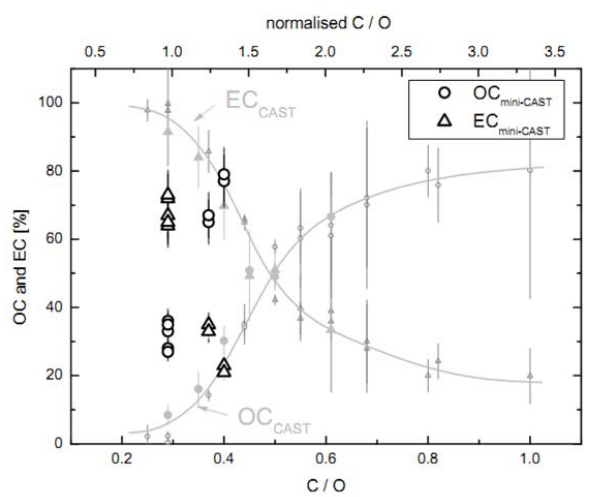
Fig. 3. Dependence of the particle composition (OC and EC con- tent) on the C/O atomic ratio in the burner. Full symbols indicate measurements on samples from the NAUA chamber, open symbols indicate samples taken directly behind the CAST burner. For further details see Schnaiter et al.